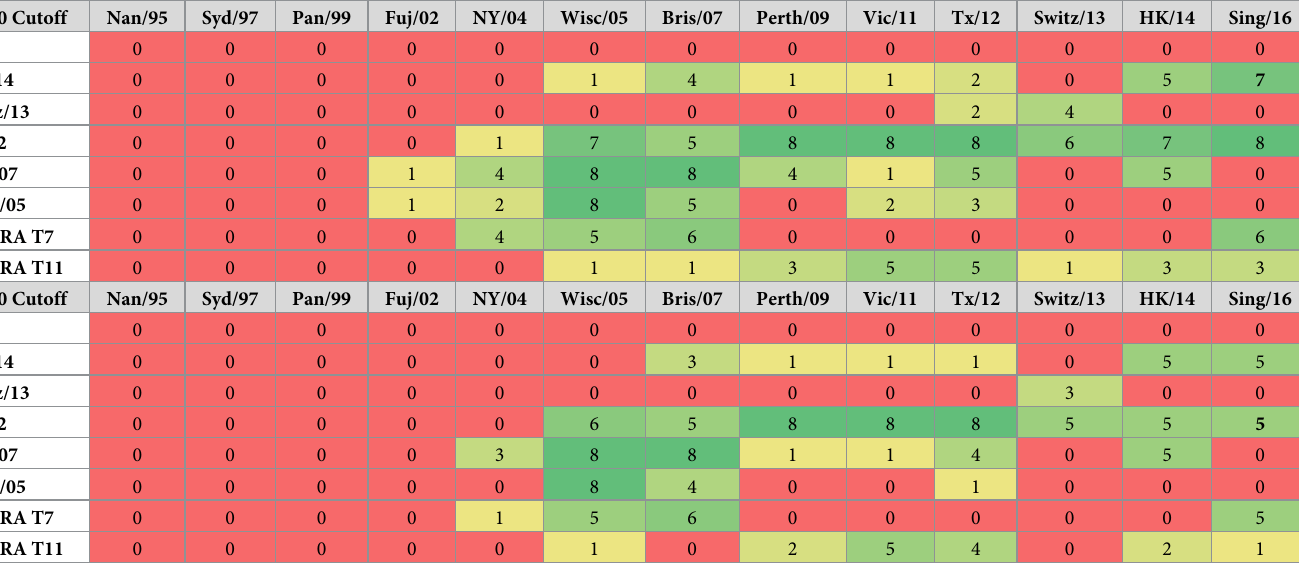
Table 2. Historical vaccine strain panel (1995–2016) HAI heat map.